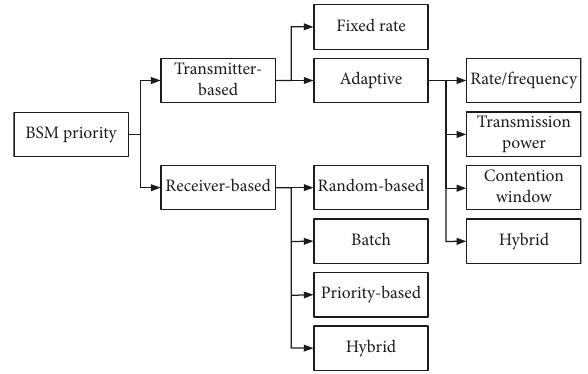
Figure 1: Categorization of the safety message prioritization scheme in